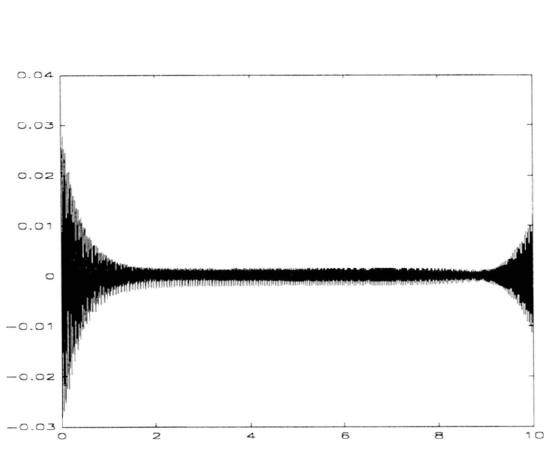
FIGURE 2 Waveform prediction error with har monic